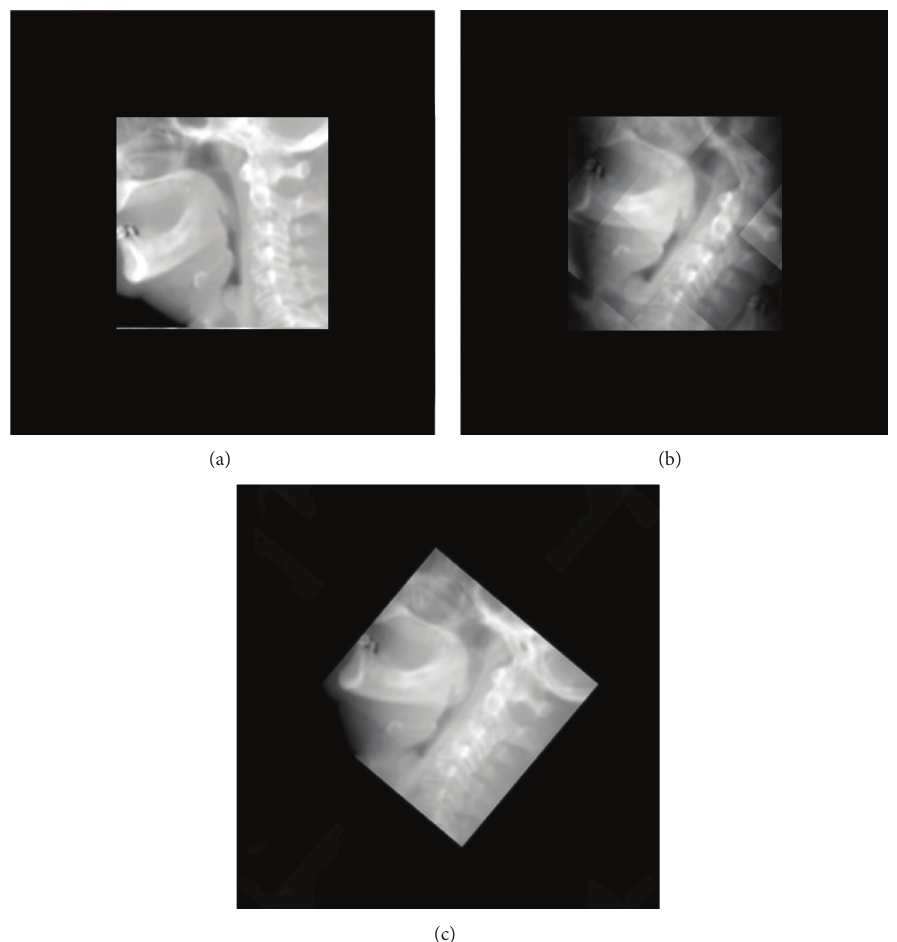
Figure 10: Zero-padding the spatial volume to remove the overlapping between the central image and the replicas. In (a), the central part of the visible male dataset is packed in a volume array of the same size. Rotating the volume in (b) results in overlapping. Zero-padding the subvolume removes all the overlapping after rotating the whole volume as shown in (c).